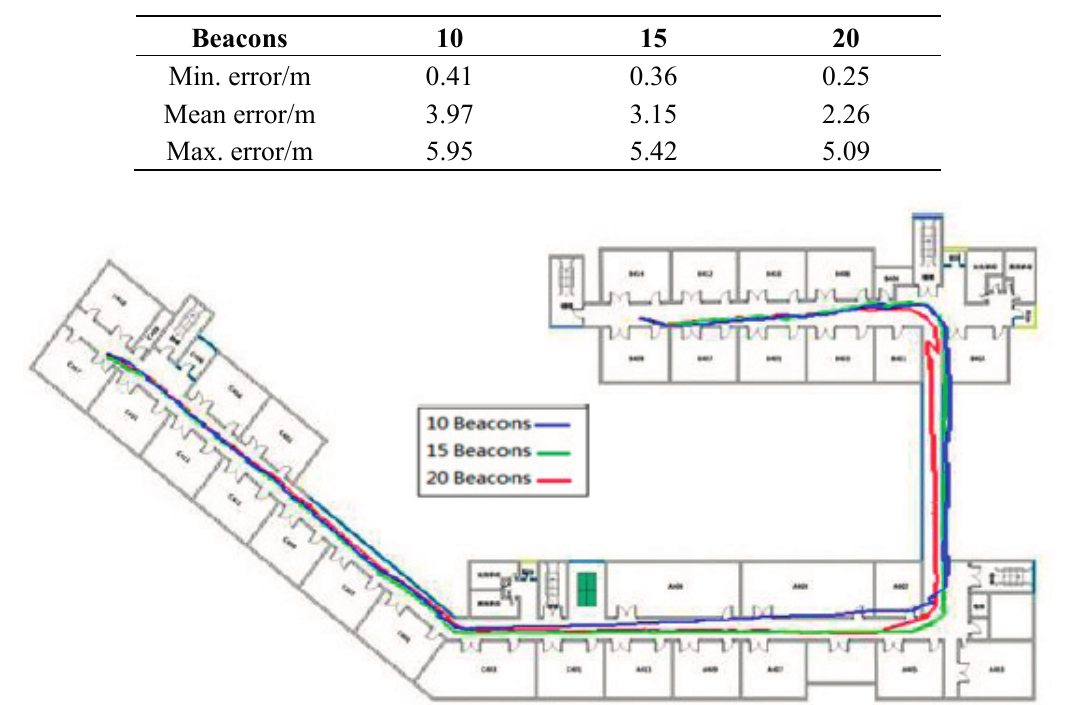
Figure 13. Positioning trajectory analysis for different numbers of